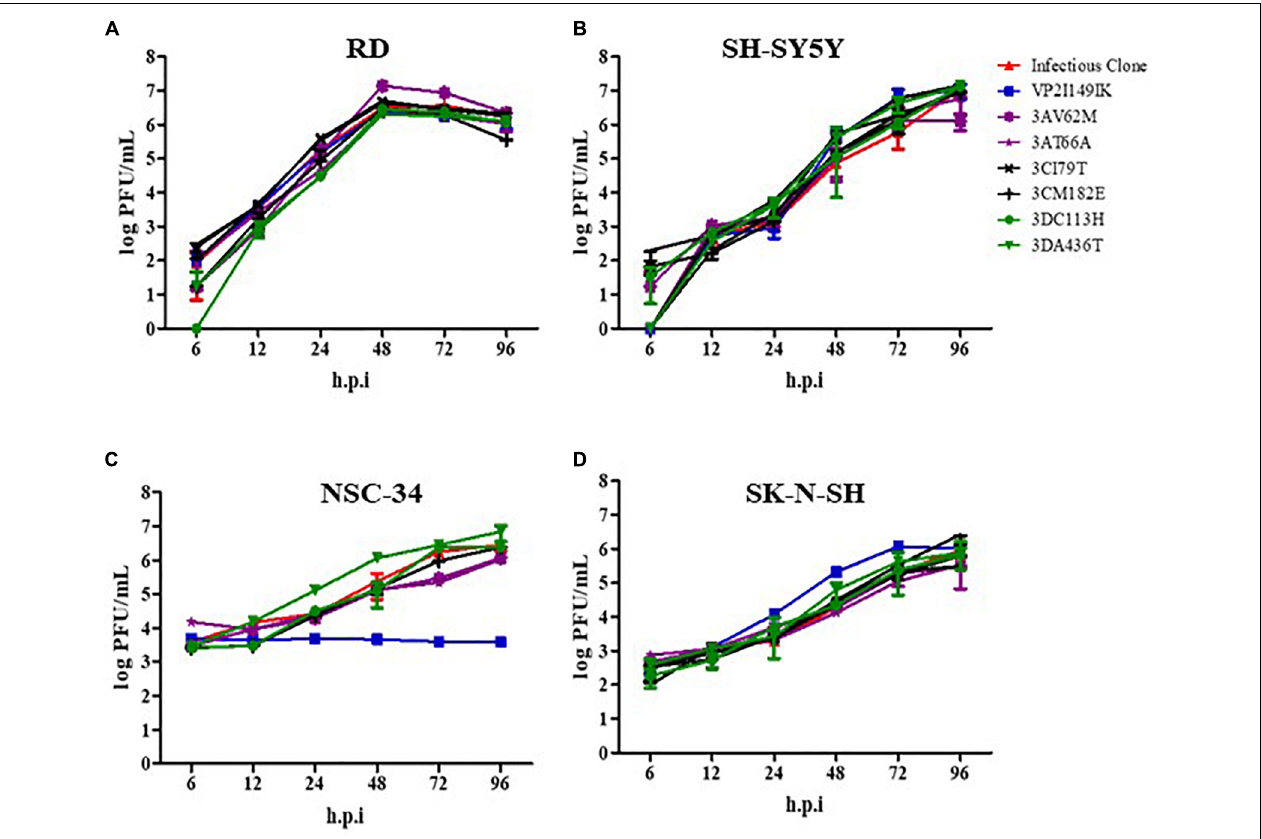
FIGURE 1 | Infection profiles of EV-A71 WT and mutant strains. RD (A) , SH-SY5Y (B) , NSC-34 (C) and SK-N-SH (D) cells were infected with the WT S41 strain and the various mutants at MOI of 0.001 (RD and SH-SY5Y), 0.1 (SK-N-SH), and 1 (NSC-34). Supernatants were harvested at the indicated time-points p.i., and the virus titers were quantified by plaque assay. One set representative of two independent experiments is shown. Data were expressed as mean ± SD.